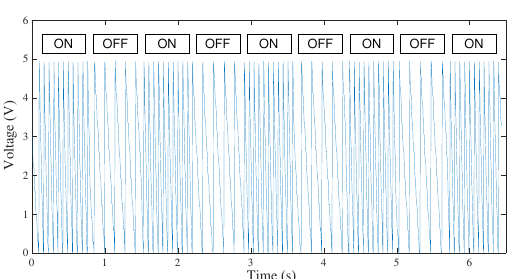
Figure 8. Blue-to-red link, T = 700